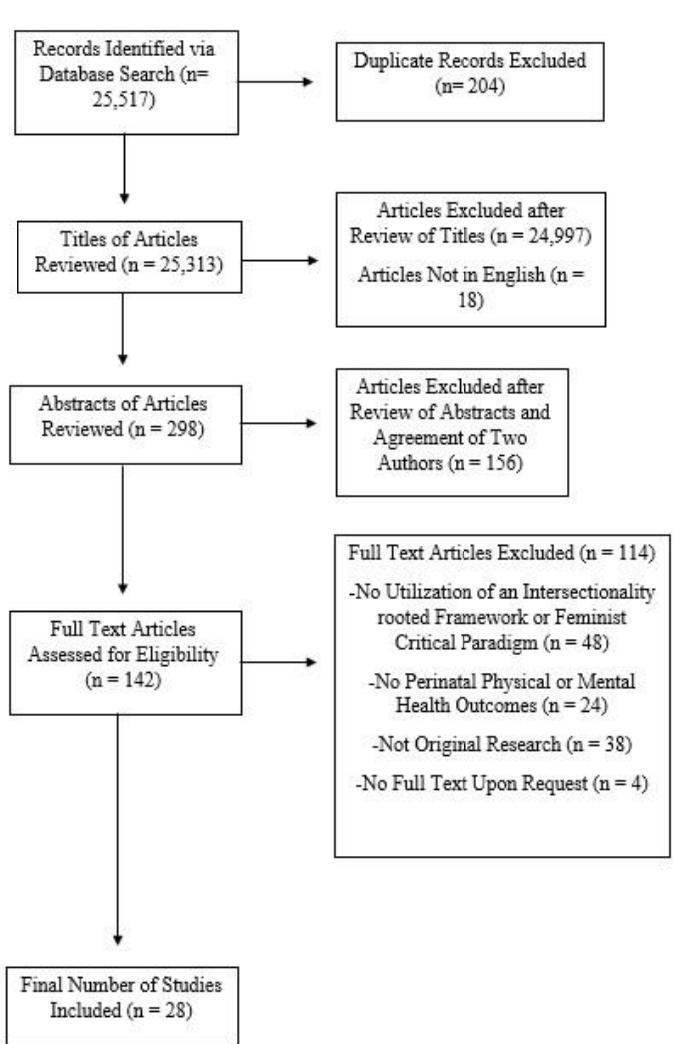
Figure 1. Flowchart of the search and criteria for inclusion in our scoping review.